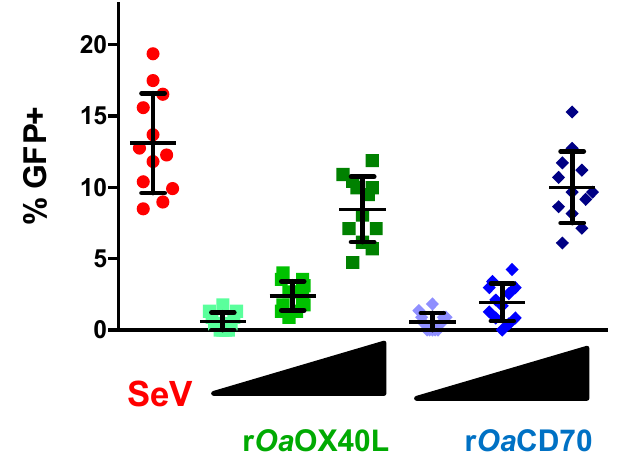
Figure 6. Dose dependent induction of signalling by r Oa OX40L and r Oa CD70 ligands. HEK-293 / prIFNB-GFP cells were transfected with plasmids to express the receptors Oa OX40 or Oa CD27 and stimulated at 24 h post transfection with three equivalent and increasing doses (1 × , 2 × , and 4 × ) of conditioned media from Ad5- Oa OX40L (r Oa OX40L) or Ad5- Oa CD70 (r Oa CD70) infected Vero cells. As a positive control of signalling induction, untransfected cells were infected with Sendai virus (SeV) at a multiplicity of infection (moi) of 1 pfu / cell for 16 h. GFP expressing cells were counted on an immunofluorescence microscope on 12 randomly chosen fields and % of GFP expressing cells for each field are plotted. Mean ± SD for each condition are indicated with bars.